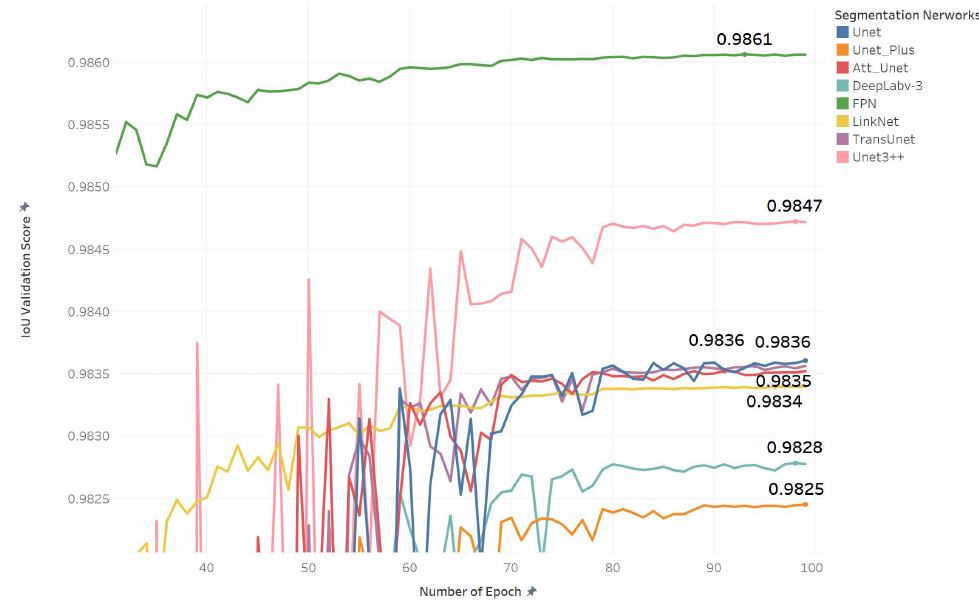
Figure 5. Segmentation networks performance based on IoU validation score during training with 128 × 128 input